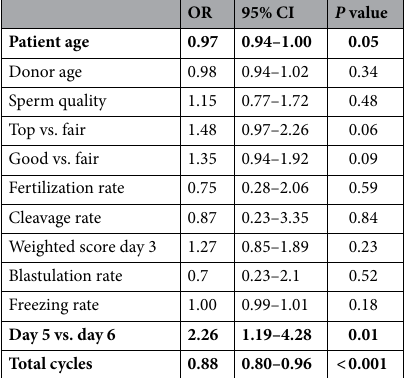
Table 5. Logistic regression model of the possible factors associated with live birth rate in vitrified blastocyst cycles on egg donation program,